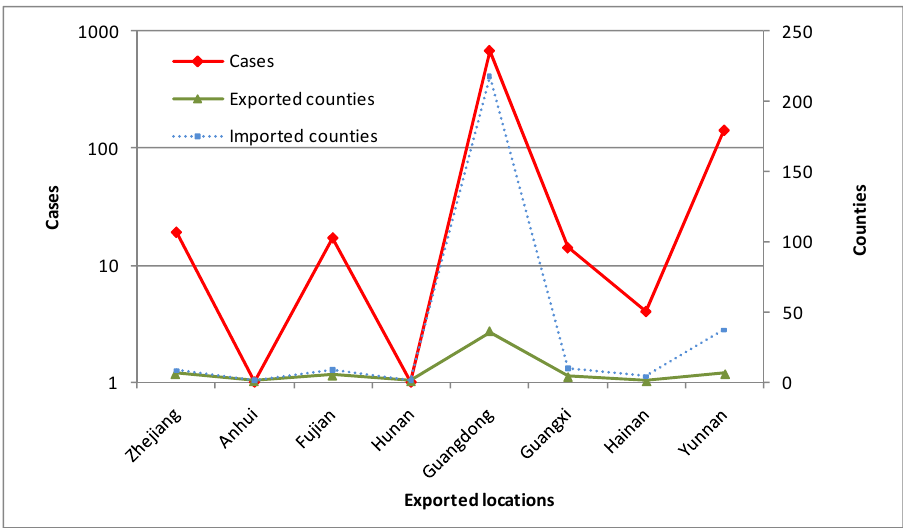
Figure 2. Cases and counties in central exported locations.